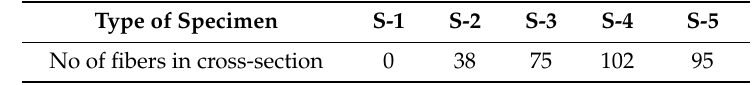
Table 2. Average no of fibers in cross-section of each type samples.